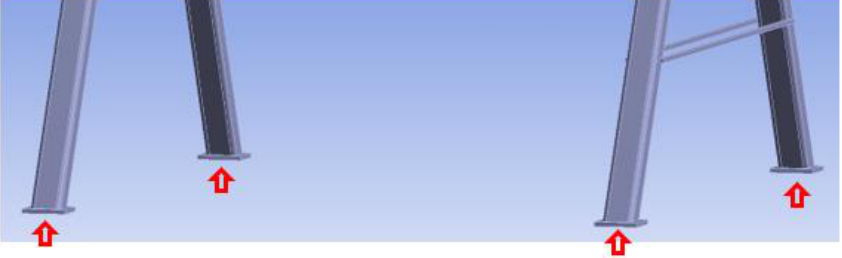
Figure 8. Boundary conditions of the numerical models.